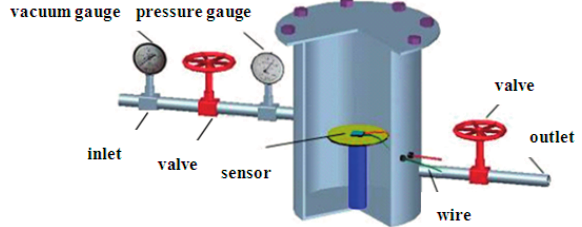
Figure 2. Schematic of the experimental